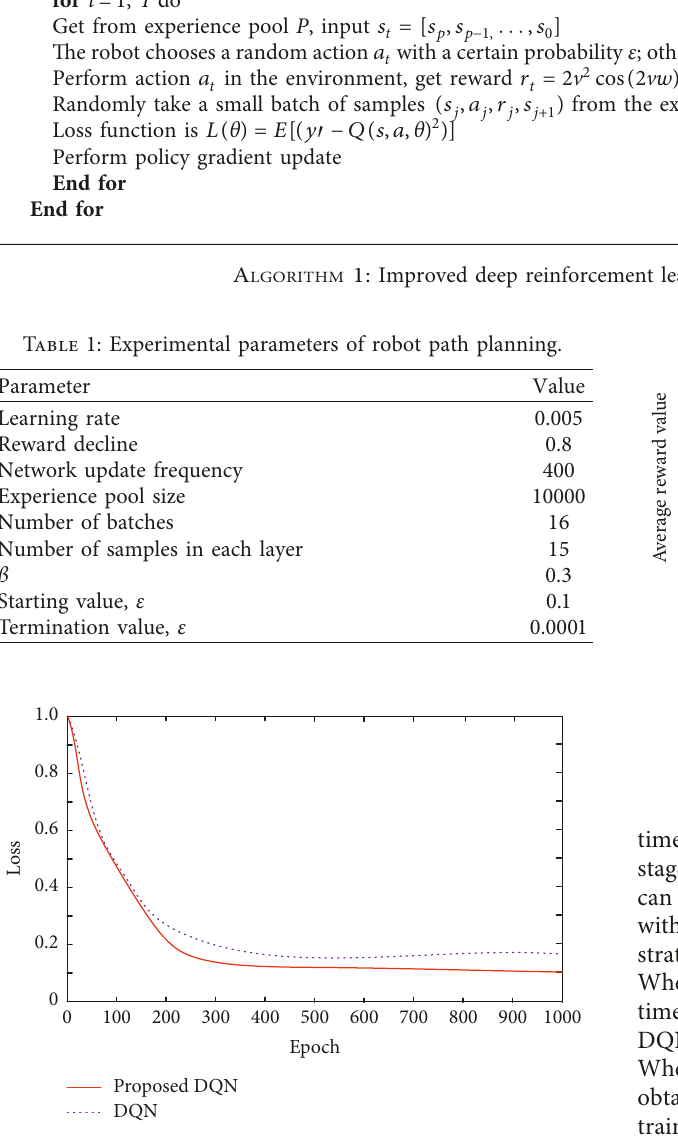
Figure 5: Comparison diagram of loss function values.